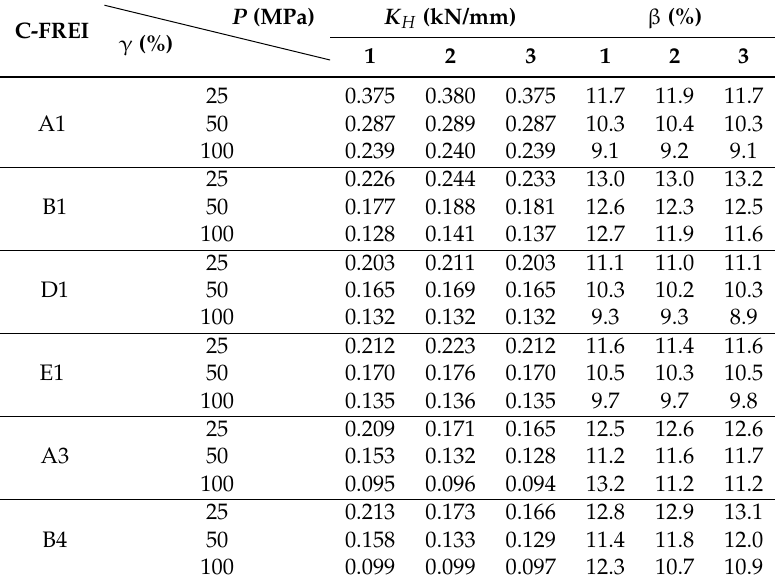
Table 2. Effective horizontal stiffness and equivalent viscous damping of C-FREIs at different shear-strain amplitudes and vertical